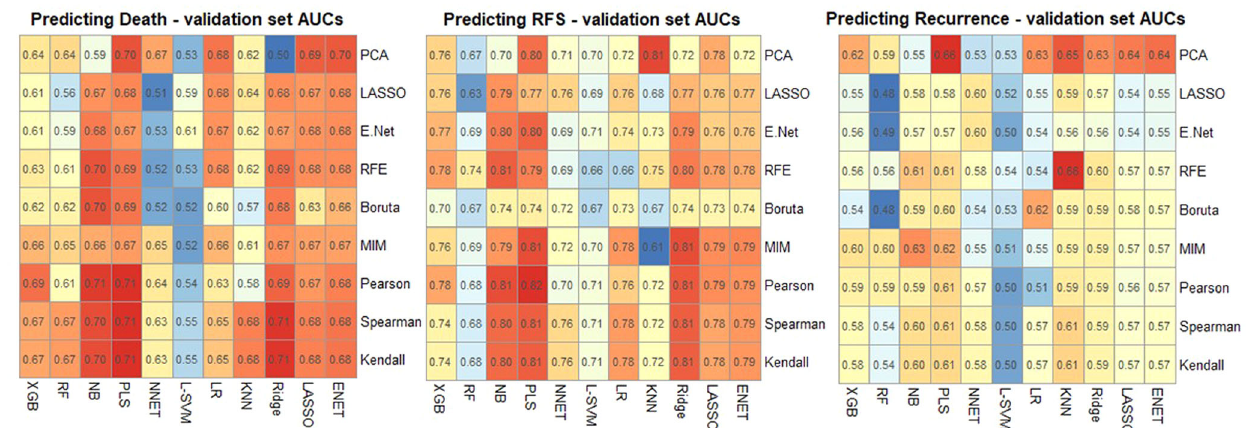
Fig. 3 Heatmaps illustrating the performance of each machine learning algorithm (columns) with each feature reduction technique (rows), measured by validation set AUC. PCA Principle Component Analysis, LASSO Least Absolute Shrinkage and Selection Operator, E Net Elastic-Net, RFE Recursive Feature Elimination, MIM Mutual Information, XGB Extreme Gradient Boosting machine, RF Random Forest, NB Naïve-Bayes, PLS Partial Least Squares, NNET Neural Network, L-SVM Linear Support Vector Machine, LR Logistic regression, KNN K-Nearest Neighbours, Ridge Ridge regression. The best performing models were, for OS Spearman correlation with PLS, for RFS Pearson correlation with PLS and for recurrence: PCA with an ensemble of PLS, KNN and E